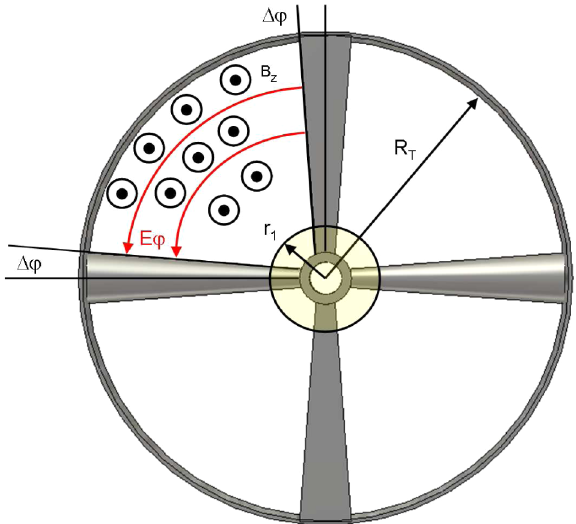
FIG. 7. Magnetic field B for two CH structures with geometrical betas of 0.07 and 0.25.